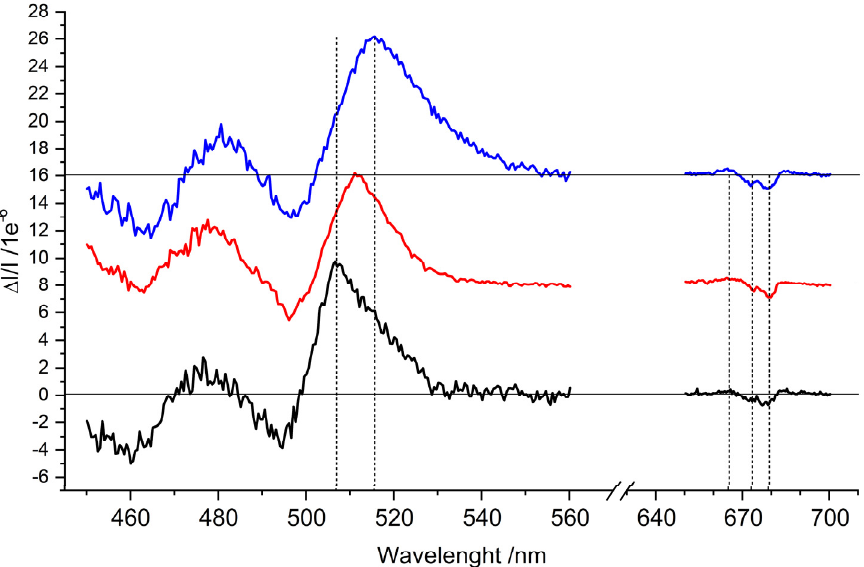
Figure 4. 3 Car T–S spectra of the WT (black), lut2 (red), and lut2 npq2 (blue) LHCII variants. Resonance frequency of about 225 MHz, amplitude modulation of 333 Hz, time constant of 3 s, and temperature of 1.8 K. The spectra of the lut2 mutant (red) and the lut2 npq2 mutant (blue) were vertically translated for a better comparison. The vertical dashed lines highlight the main transitions.